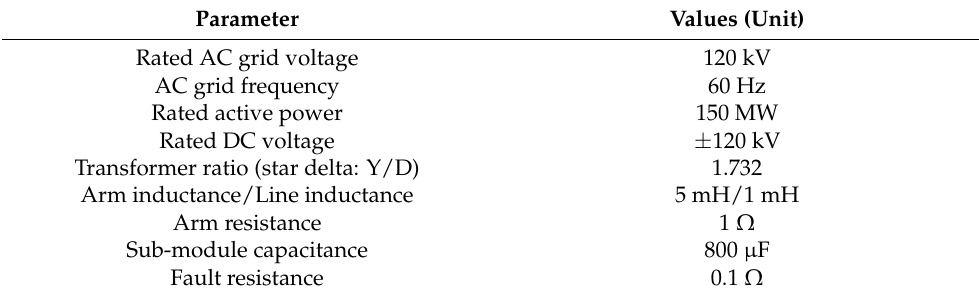
Table 2. Circuit parameters for simulation.